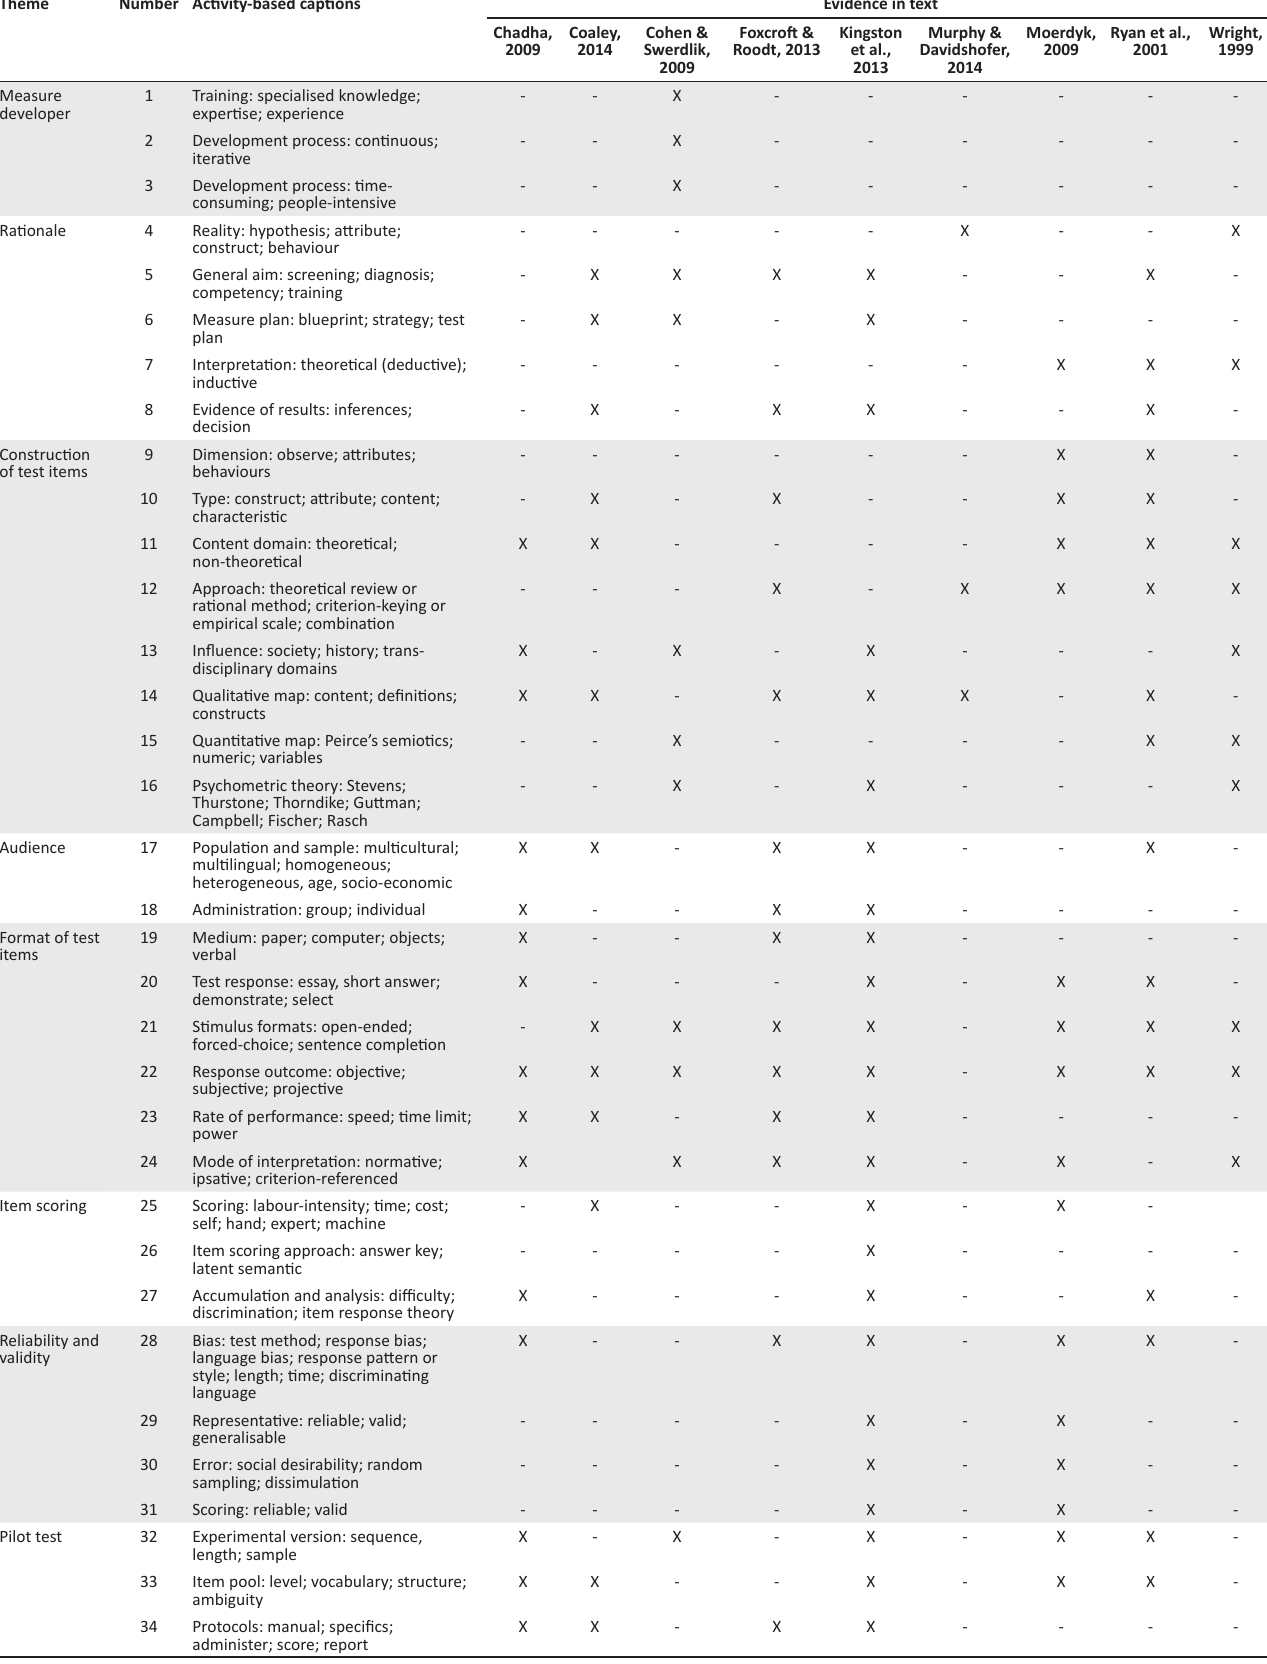
TABLE 1: Psychometric and psychological literature pertaining to the ‘conceptualisation